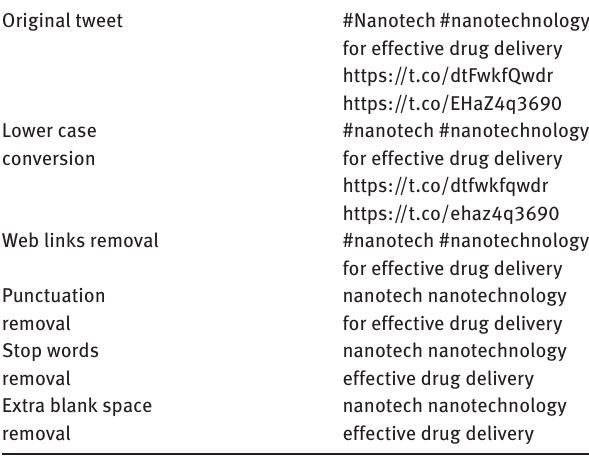
Table 2: Preprocessing results.